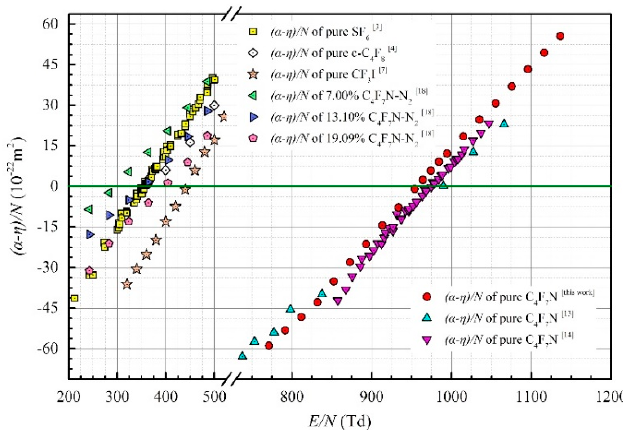
Figure 4. Comparison of the normalized effective ionization coefficient in different gases.